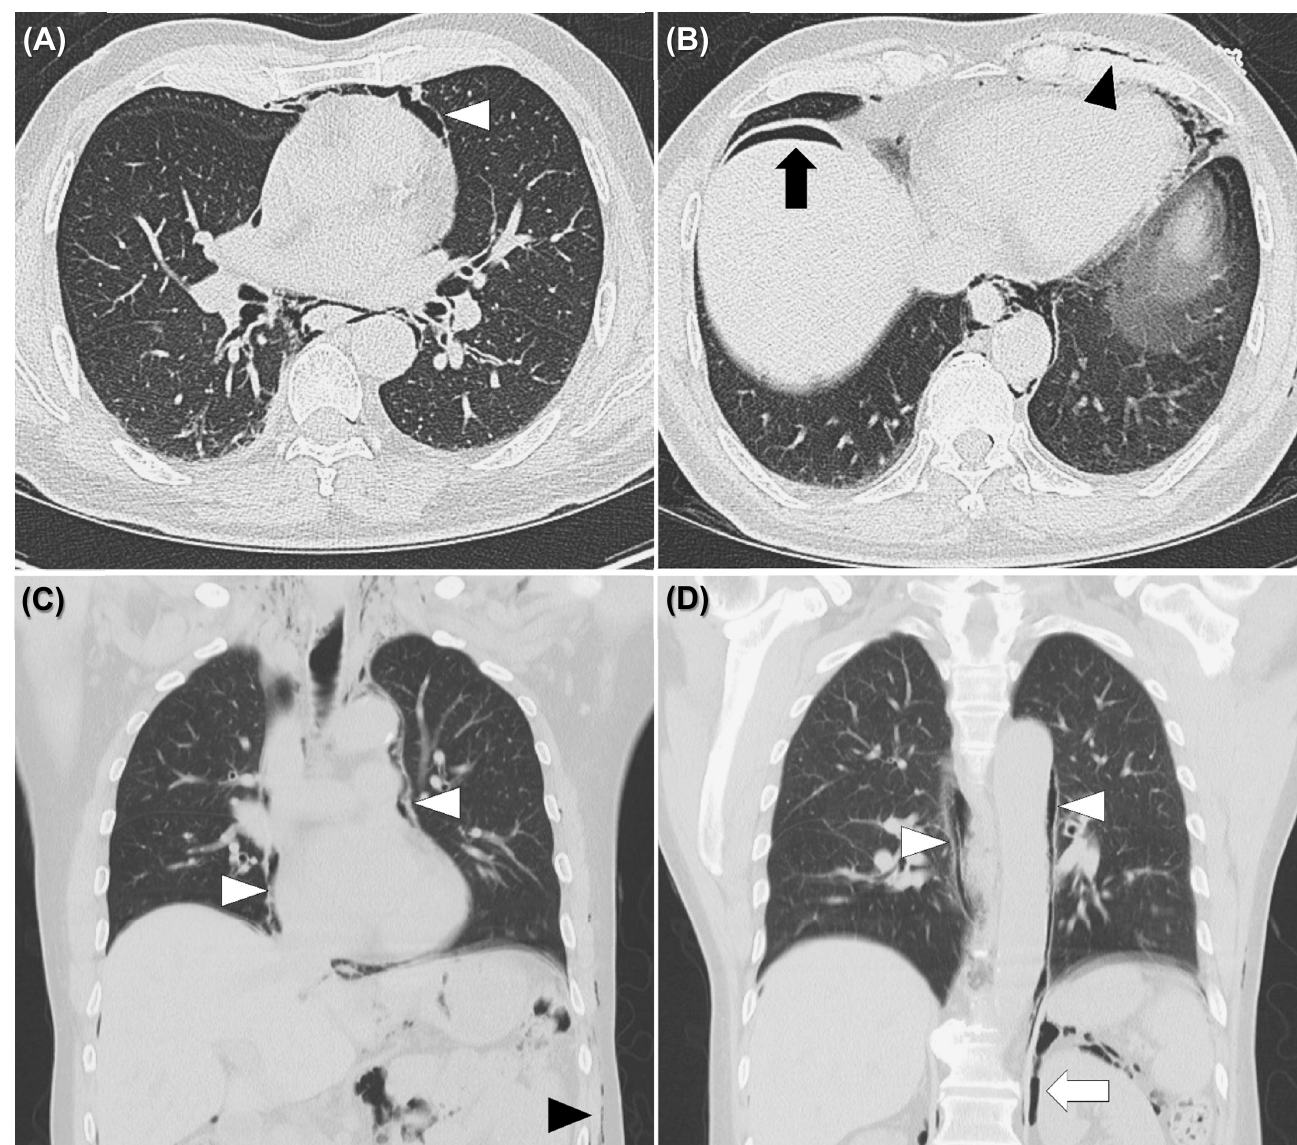
Figure 4. Non-enhanced computed tomography of the chest showed pneumomediastinum (white arrowheads) ( A , C , D ), subcutaneous emphysema (black arrowheads) ( B , C ), pneumoperitoneum (black arrow) ( B ), pneumoretroperitoneum (white arrows) ( D ), but no evidence of rib fracture and pneumothorax.